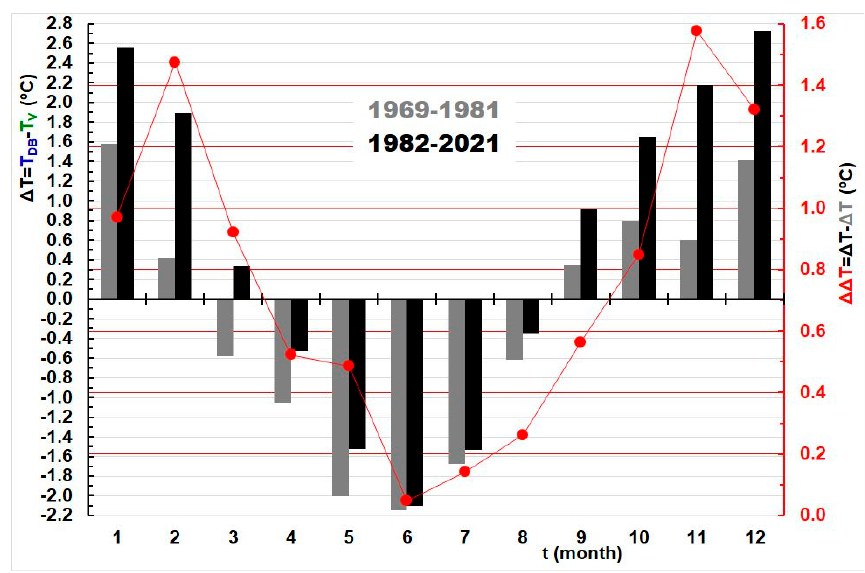
Figure 9. Histograms of average monthly differences in water temperature of the Drava at the station Botovo, T DB , and the air temperature at Varaždin, T V , Δ T = T DB − T V , during the two subperiods: 1969–1981 (grey color) and 1982–2021 (black color). A line graph of their differences, ΔΔ T , during the two subperiods above is shown in red. Table 6. Average values of the subseries of monthly water temperatures of the Drava near Botovo (1969–1981 and 1982–2021), T DB , the subseries of Varaždin air temperature, T V , and the subseries of their differences, ∆ T = T DB − T V , and the probability of the t -test,